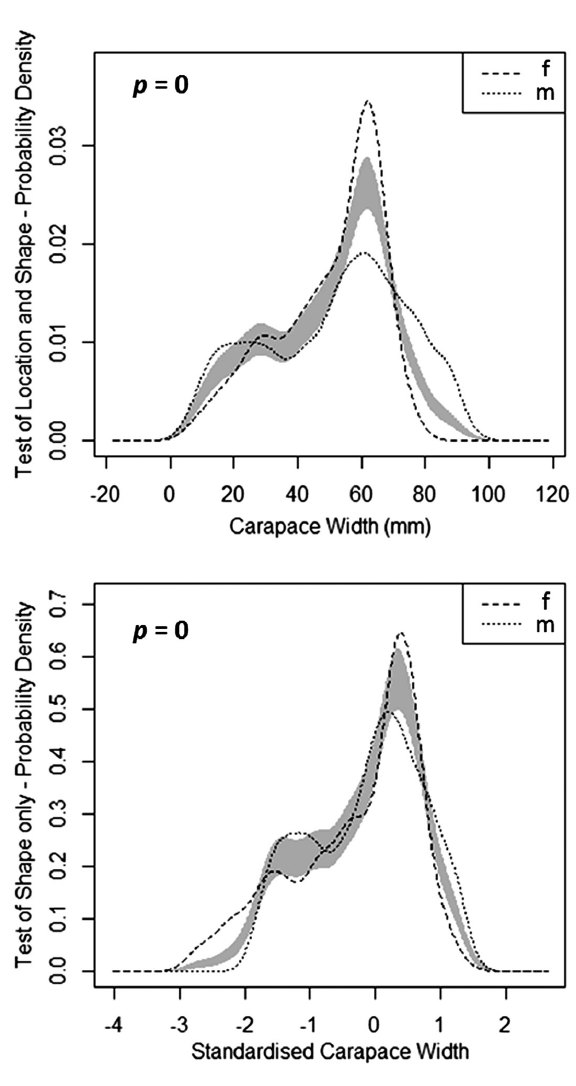
Fig. 3. – Sexual size dimorphism in Platyxanthus crenulatus . Com- parison of kernel density estimate (KDE) probability density func- tions estimated for both sexes. Grey bands represent one standard error either side of the null model of no difference between the KDEs for each sex. Significance tests (p) were based on permuta- tion tests of the area between the two probability density functions. Significance tests on raw data (top) provide a test of differences in both site and shape of the length-frequency distributions, whereas tests on standardized data (bottom) provide a test of shape